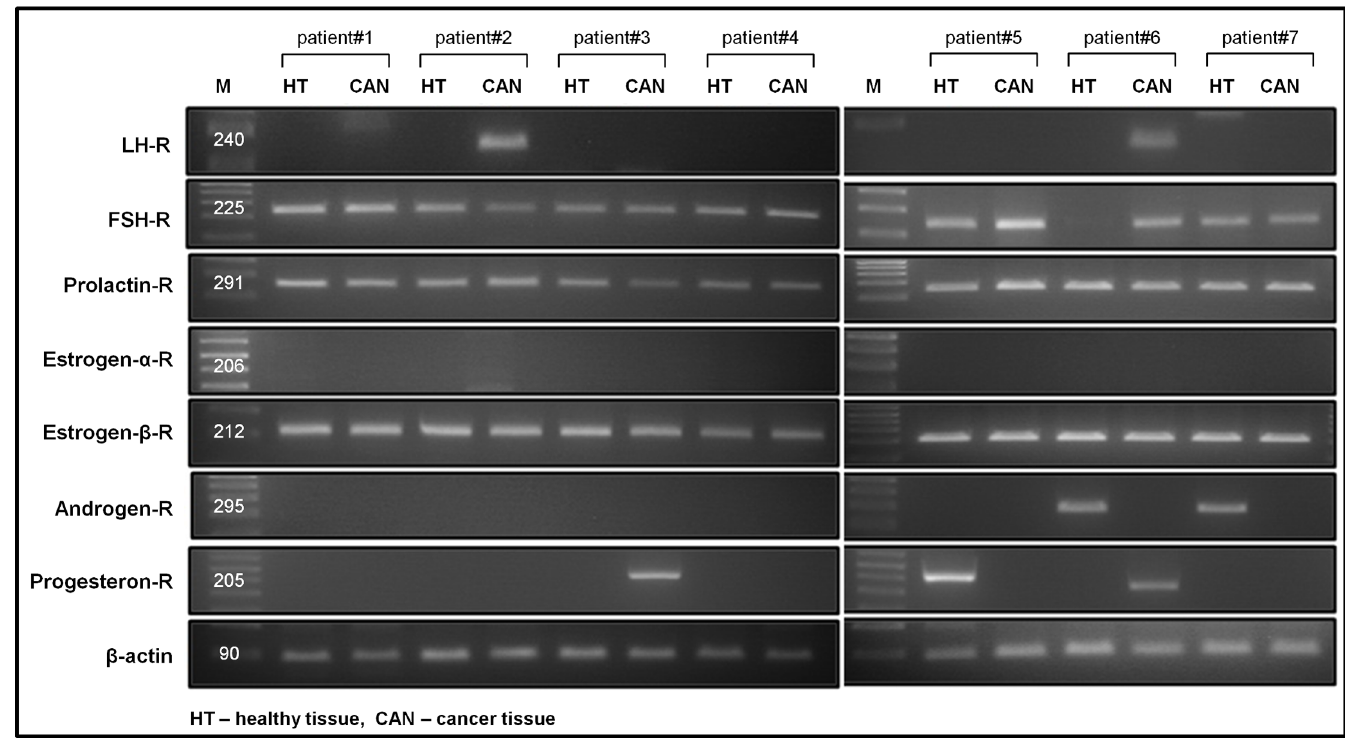
Fig 6. Pituitary gonadtropins and gonadal sex hormone receptors are expressed in colon cancer patient samples. RT-PCR assays demonstrate SexH RNA expression in healthy human colon tissue (HT) and tumor colon tissue (CAN) in seven cases (n = 7). The assay was performed three times with similar results. A representative gel image is